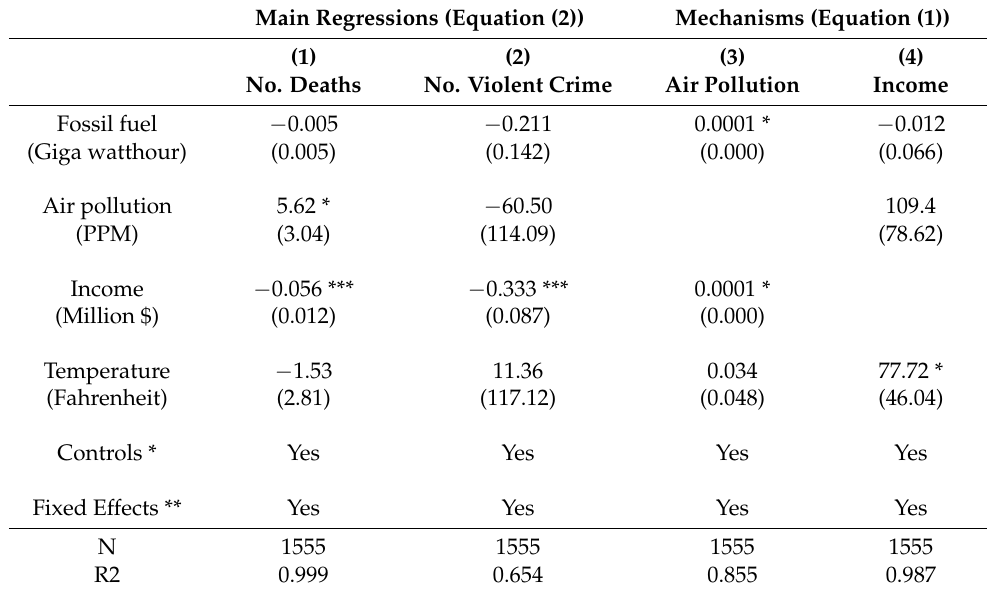
Table 3. Using the original mechanism approach (Equations (1) and (2)), when air pollution and income level are the mechanism and fossil fuel consumption is the independent variable: